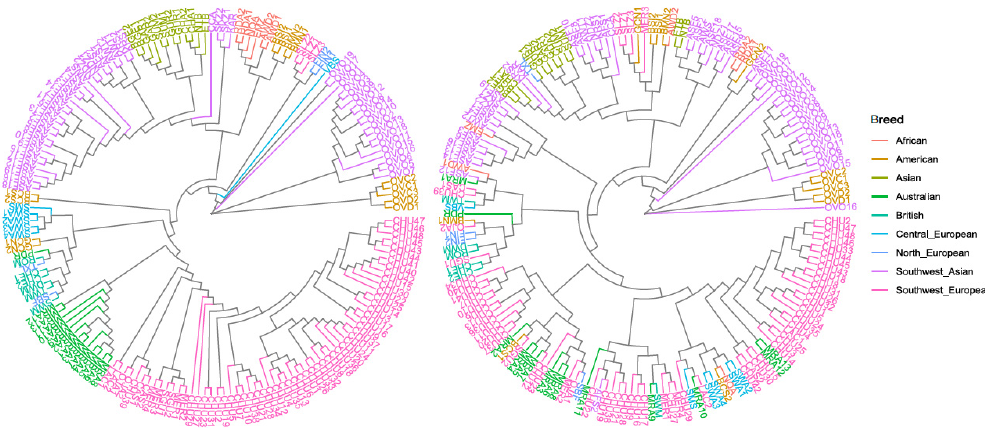
Figure 3. Phylogenetic trees based on the genetic diversity identified across the genome and across candidate gene regions studied here. Phylogenetic trees were built using the maximum composite likelihood method based on the variant diversity of a representative sample of all the identified SNPs detected across the genome ( left ) and the SNPs detected within the milk candidate genes genomic regions considered in this work ( right ). Phylogenetic trees were drawn using the neighbor-joining method to represent the relationship among all samples analyzed in this study (wild and domestic sheep). The breeds are represented in different colors according to the geographical region to which they belong. Table 1. Summary statistics of the annotation analyses performed with the SnpEff and VEP software for the genetic variants identified within the studied candidate gene regions through the analysis of the WGR datasets here analyzed.